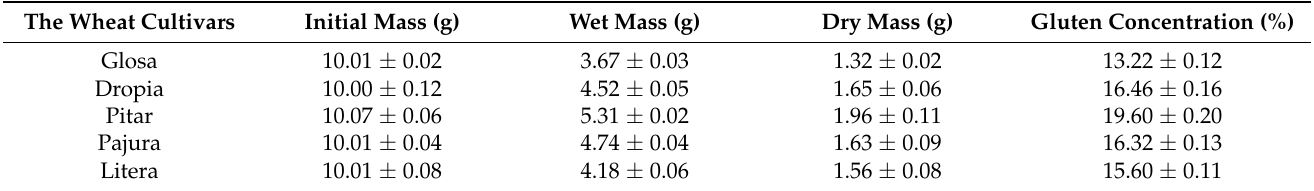
Table 3. Measured contents of gluten in wheat cultivars (means values ± standard deviation).